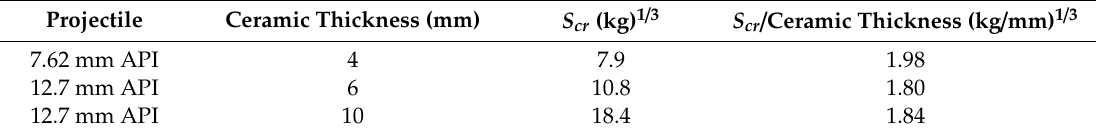
Table 6. S cr changes of the silicon carbide ceramic at di ff erent threat conditions.